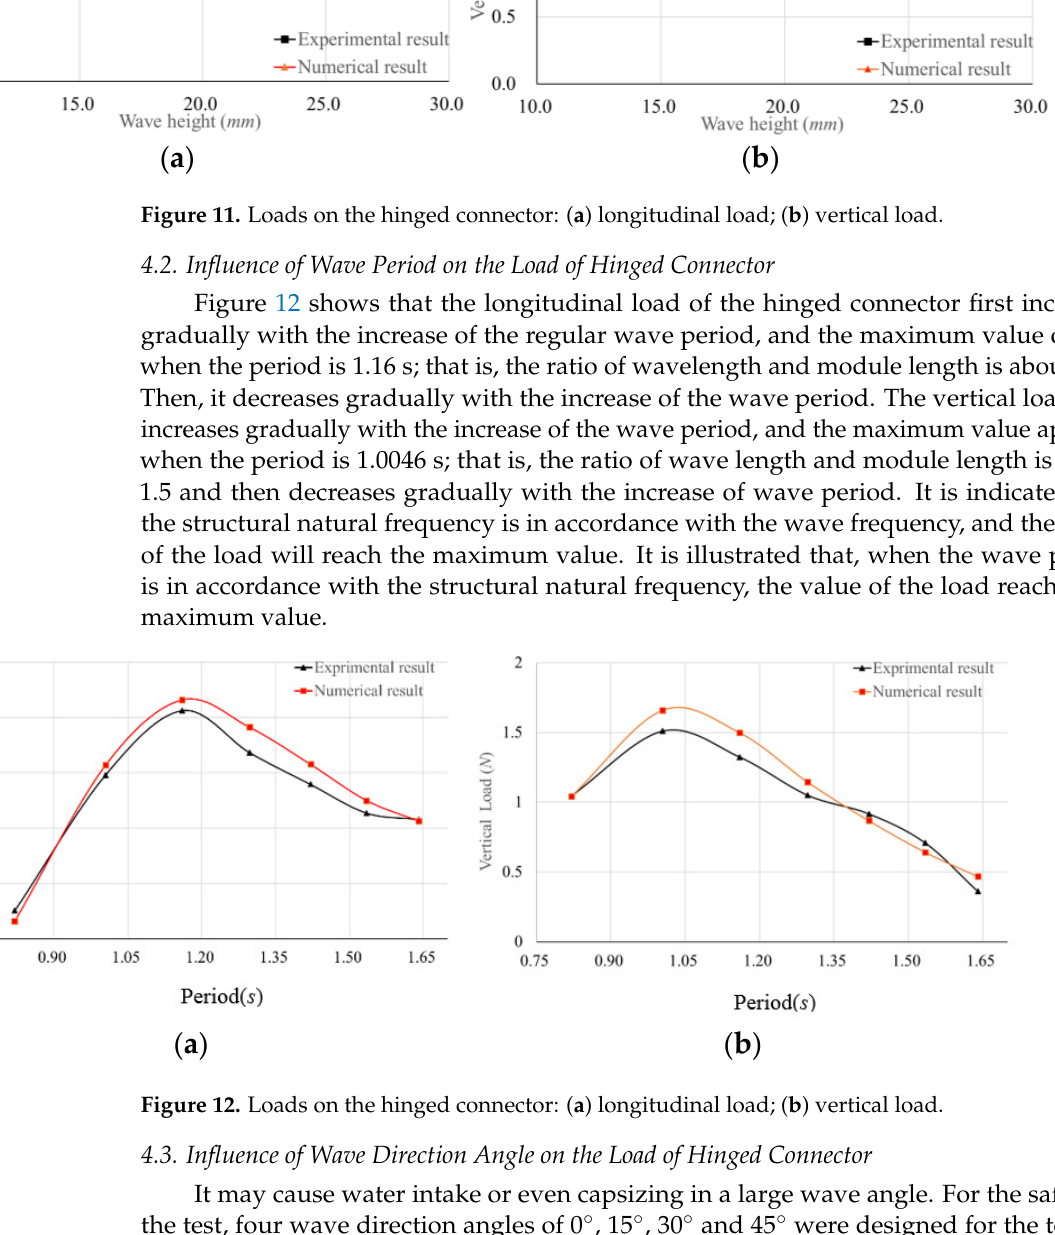
Figure 11. Loads on the hinged connector: ( a ) longitudinal load; ( b ) vertical load.